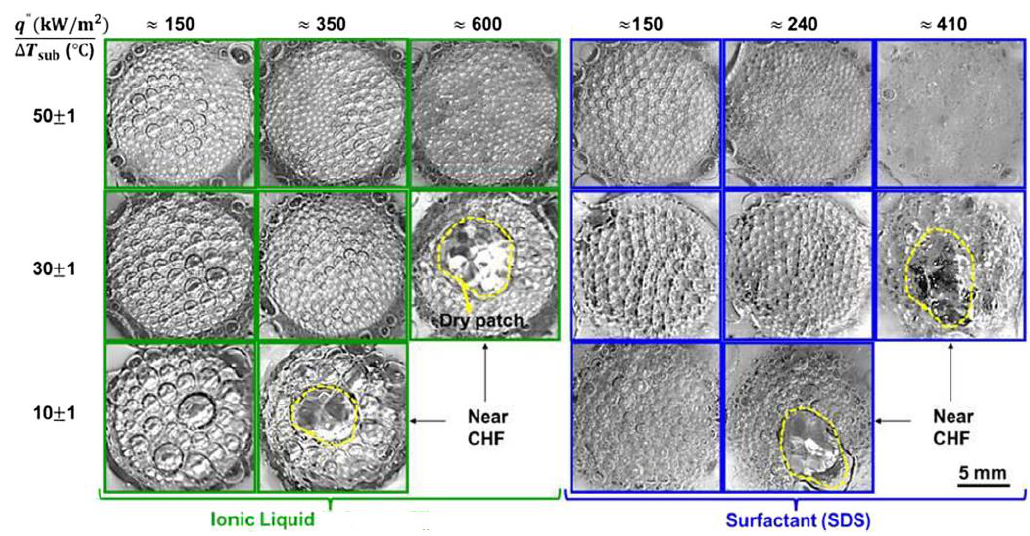
Figure 15. Bottom view images of vapor bubbles at different subcooling and heat fluxes, for aqueous solutions and SDS at critical micelle concentration, during pool boiling on an inverted heater [135].